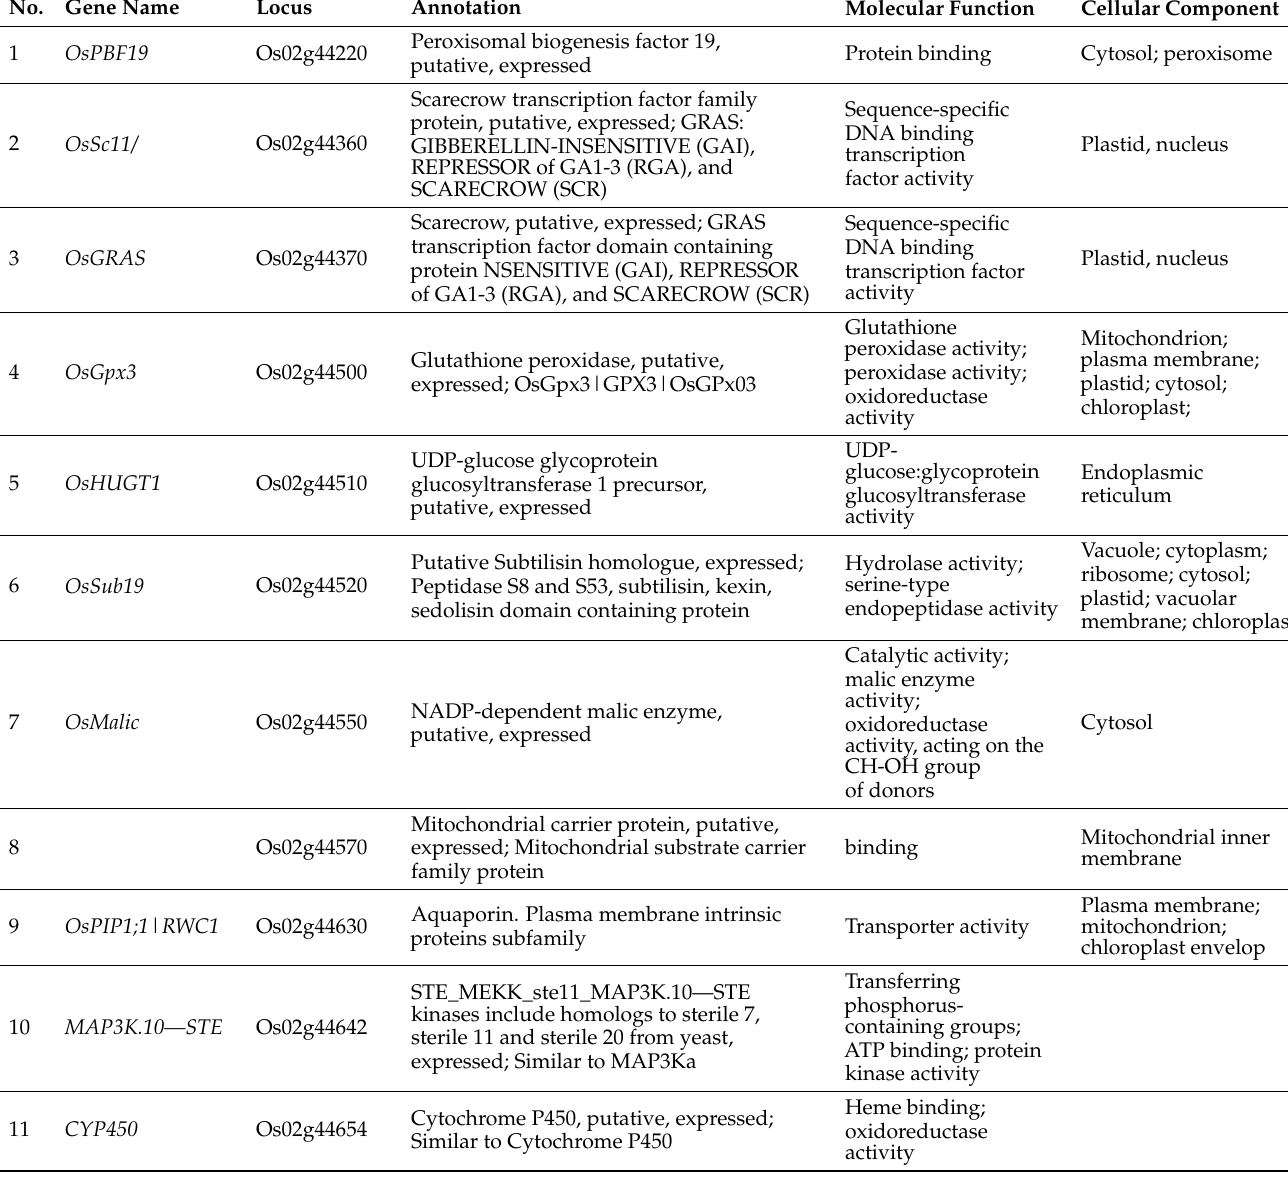
Table 3. Candidate genes pooled from the qTNL2-1 associated with tiller number under low nitrogen